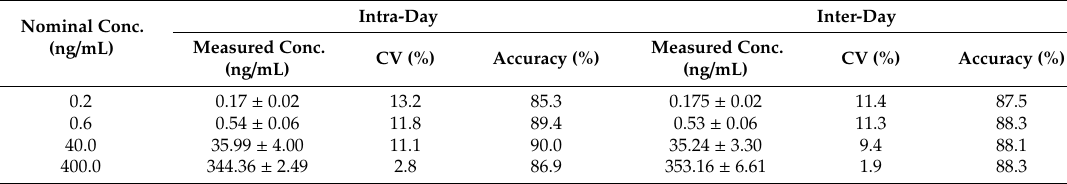
Table 1. Intra-day and inter-day precision and accuracy values of baracitinib in rat plasma. Nominal Conc. (ng / mL)